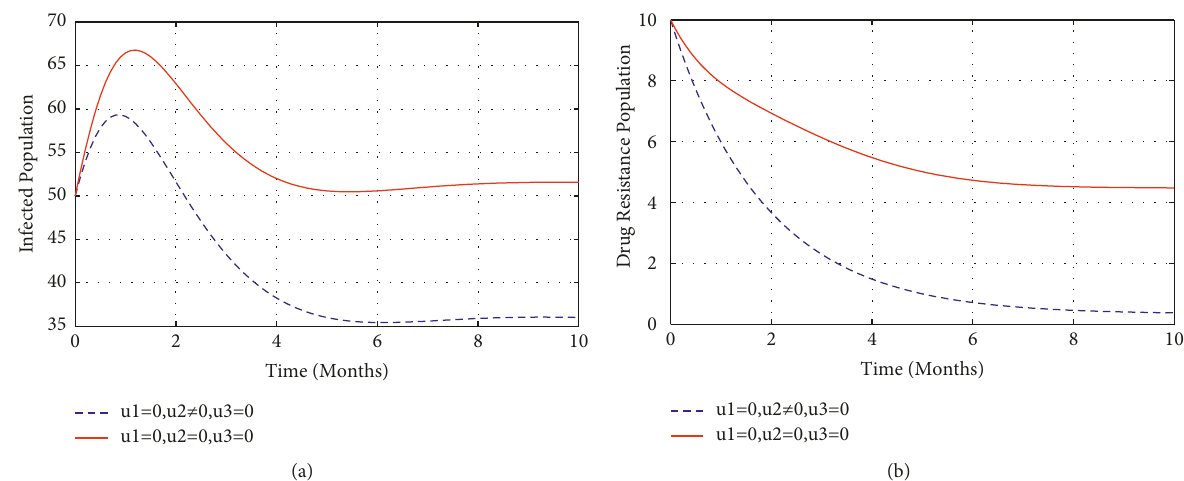
Figure 3: Impact of treatment of infectious on drug resistance and infectious